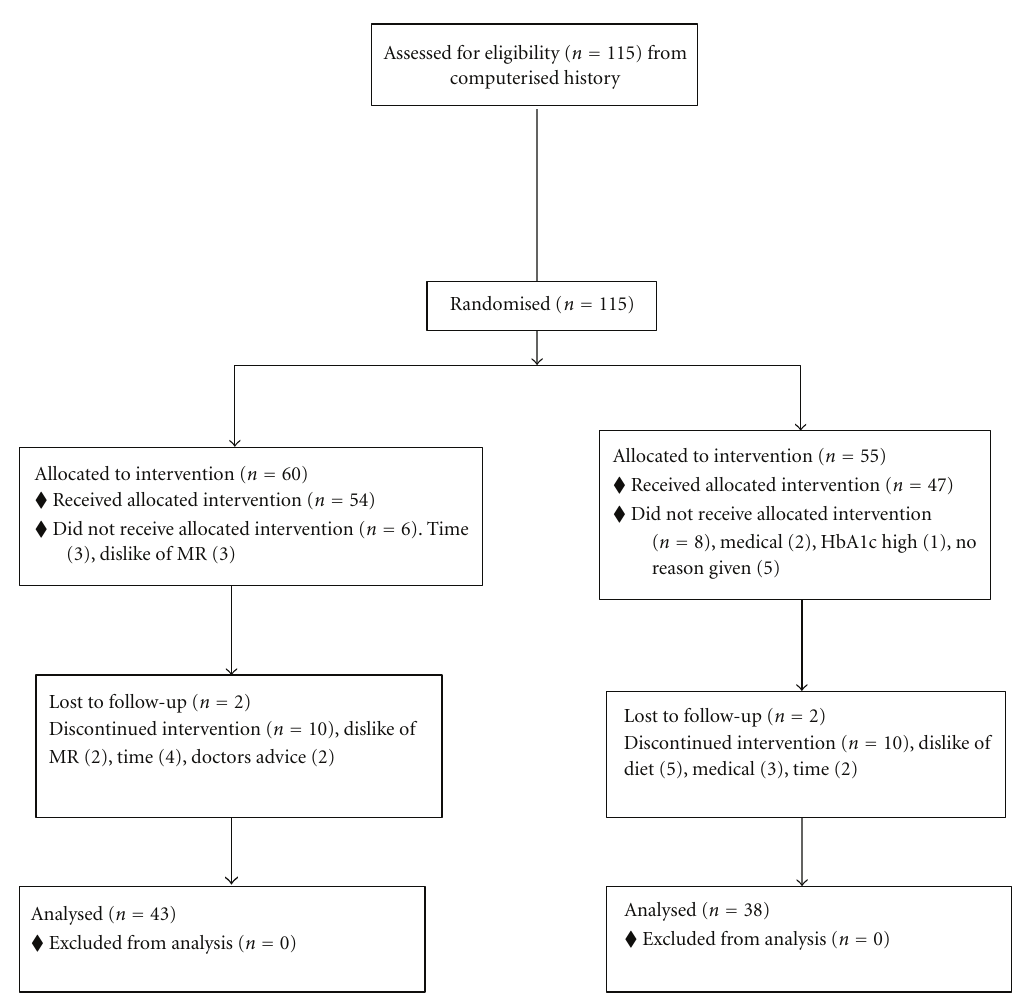
Figure 1: CONSORT flow